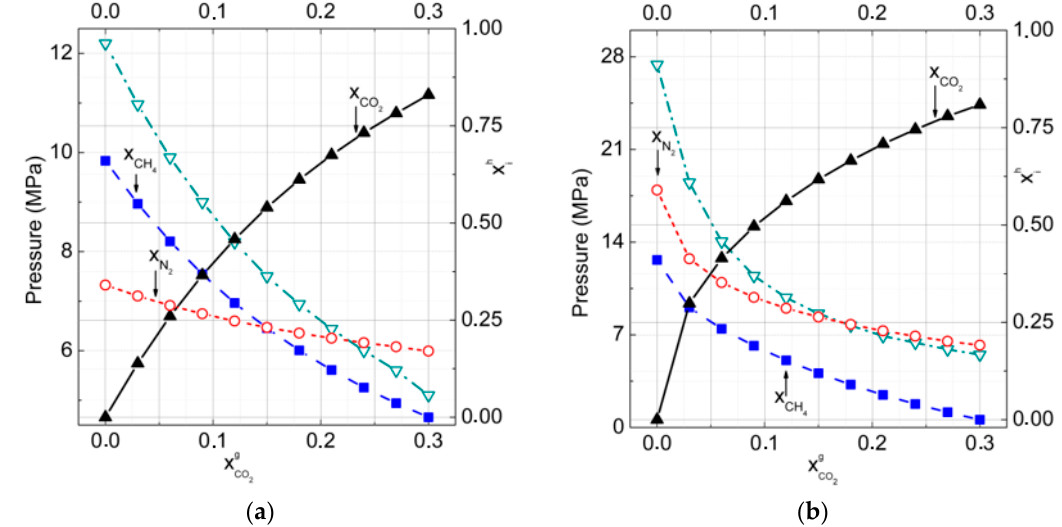
Figure 7. Formation pressure and composition of ternary hydrates carbon dioxide, methane, and nitrogen in dependence on carbon dioxide mole fraction in the gas phase.The nitrogen mole fraction in the gas phase was fixed at a value of 0.7 at temperatures of hydrate formation ( a ) T = 273 K, ( b ) T = 277 K ( P eq is dash-dotted by open inverted triangles, x CH is dashed by filled squares, x CO is solid by filled triangles, and x N is dotted by open circle lines).